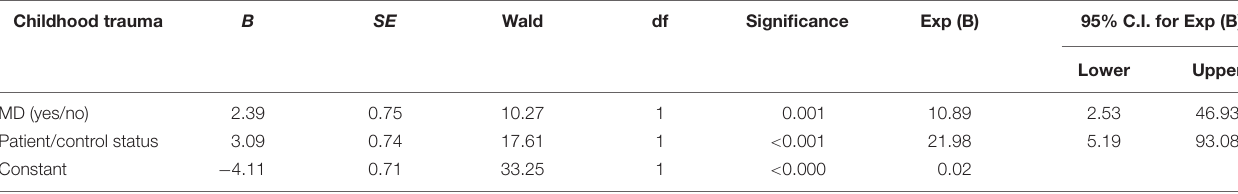
TABLE 2 | Patients reported more childhood trauma than healthy controls also after correcting for